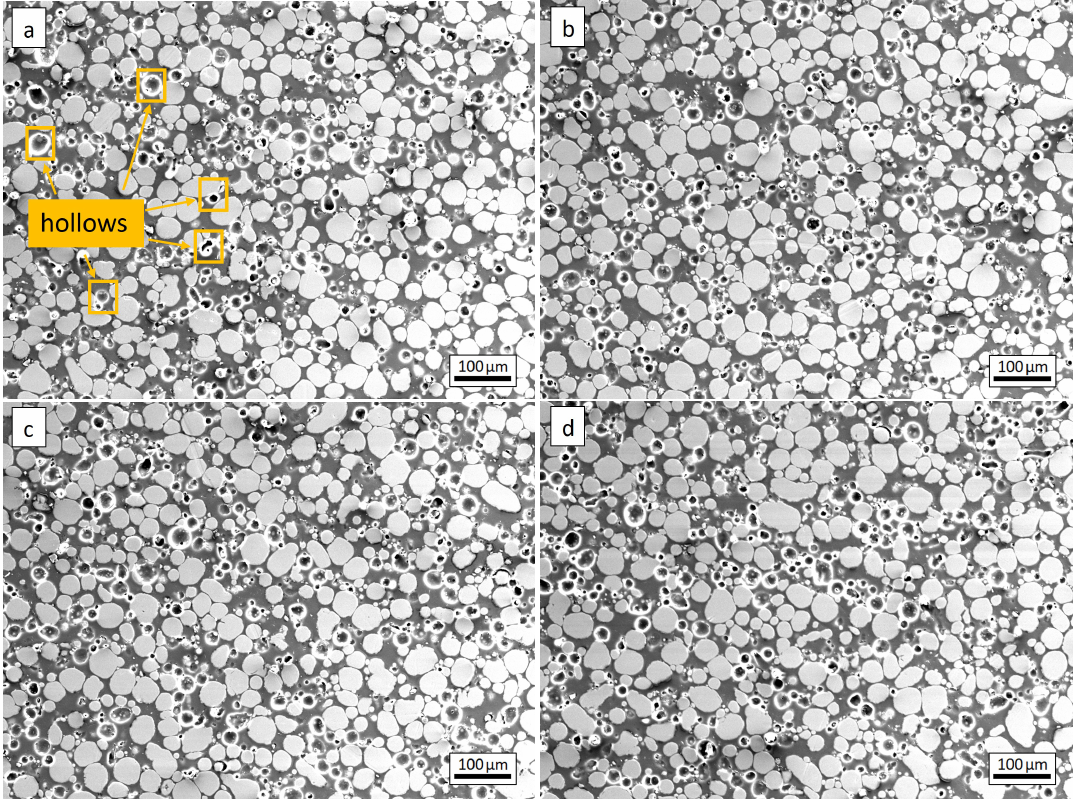
Figure 4. Microstructure of green body compacted under G = 700 at radial positions of ( a ) 0.2, ( b ) 0.4, ( c ) 0.6, and ( d )